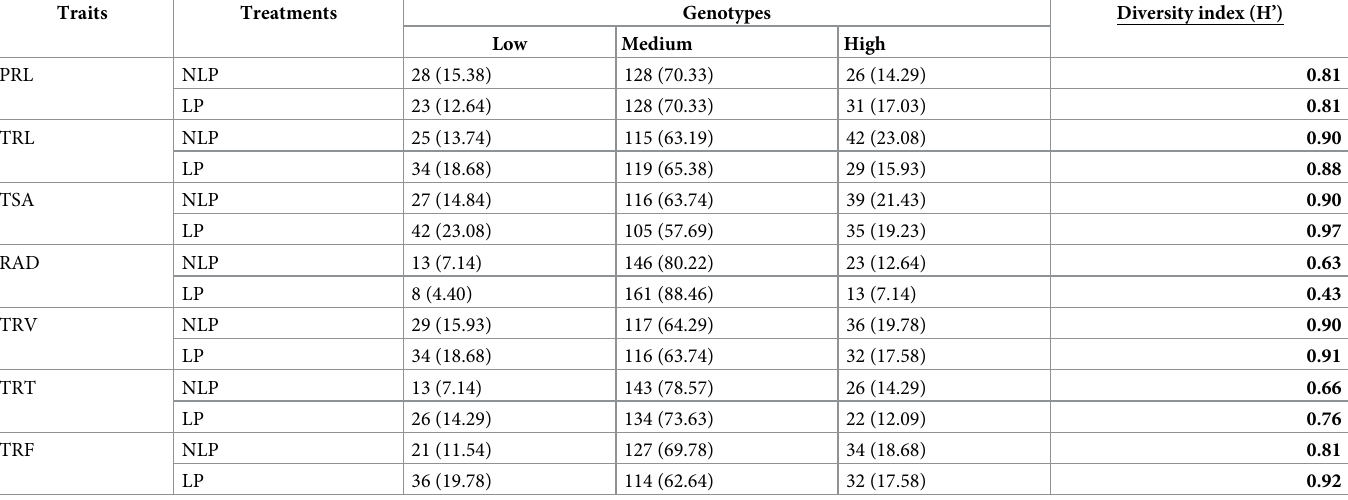
Table 4. Wheat genotypes performance classes (low, medium and high) and the diversity index (H’) for the root system architectural traits under both non-limiting and limiting phosphorus conditions. Traits